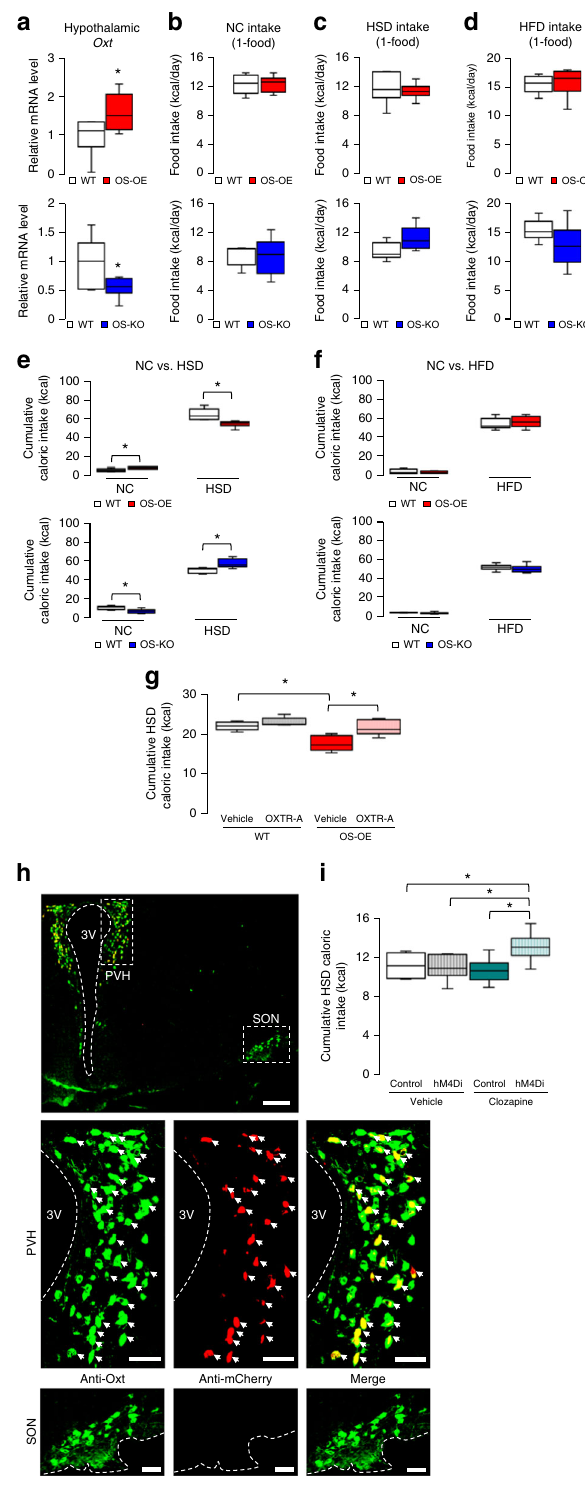
Fig. 3 SIRT1 in Oxt neurons regulates sucrose preference. a Hypothalamic Oxt mRNA expression in WT, OS-OE (red) and OS-KO (blue) mice ( n = 6 per group). b – d Food intake (kcal/d) for OS-OE and OS-KO mice fed NC only ( b ), HSD only ( c ) and HFD only ( d ) ( n = 6 per group). e , f Cumulative caloric intake for two-choice diets in 5-day diet selection experiments: NC vs. HSD ( e ) and NC vs. HFD ( f ) ( n = 6 per group). g The effect of an IP injection of the Oxt receptor antagonist OXTR-A (L-368,899) on HSD intake in OS-OE and littermate control (WT) mice ( n = 6 per group). h Representative immuno fl uorescent images of the paraventricular nucleus (PVH) and the supraoptic nucleus (SON) of the hypothalamus of OS-OE mice used in the DREADD experiments. Co-localization of Oxt (green) and mCherry (red) signals is seen in the merged image (white arrows). The size of the scale bar is 200 μ m for the low magni fi cation panel and 50 μ m for the high magni fi cation panels. i Clozapine-induced inhibition of Oxt neuronal activity by hM4Di increased HSD intake in OS-OE mice. The changes in HSD intake (clozapine-vehicle) during the course of 3-day NC vs. HSD feeding ( n = 8 per group). Data are shown as box and whisker plots (centre line, median; box limits, upper and lower quartiles; whiskers, the minimum and maximum value of a data set). * p < 0.05. 3V, 3rd ventricle. See also Supplementary Figs. 3